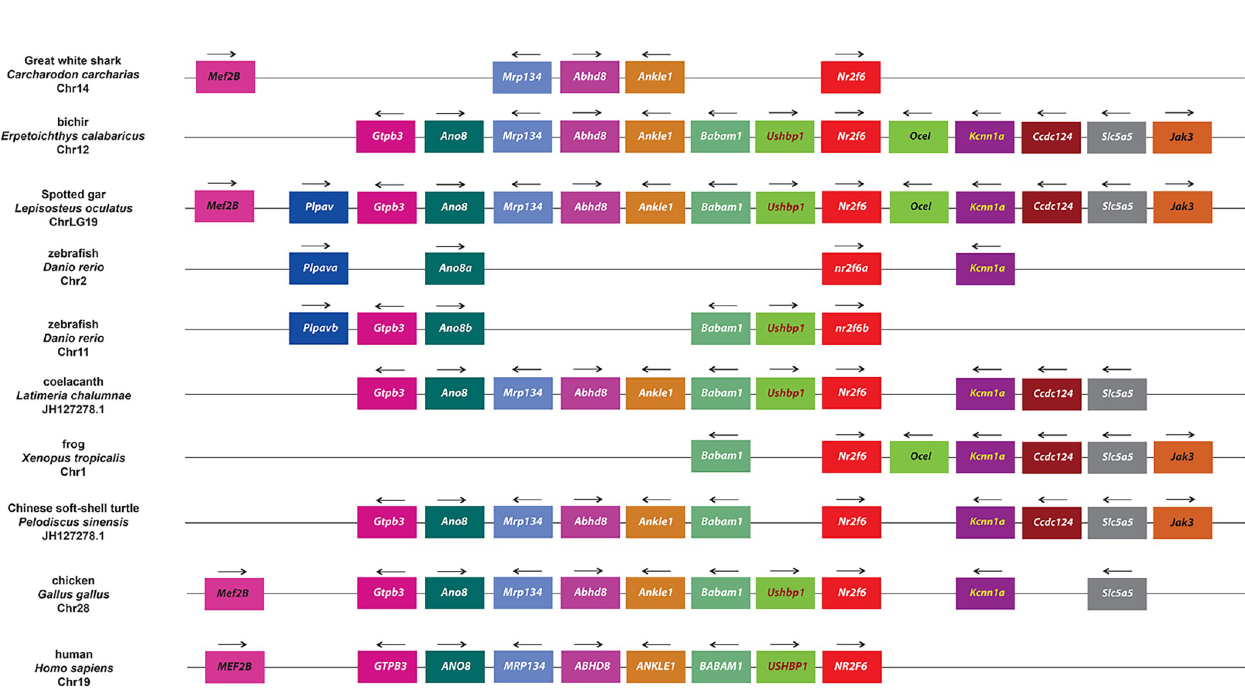
Fig 8. Synteny analysis of vertebrate Nr2f6 genes. Schematization of conserved genomic environments of gnathostome Nr2f6 genes (red rectangles) in selected species with relative chromosomes/scaffolds. Flanking orthologous genes are represented using the same color code. Arrows indicate transcription orientation.